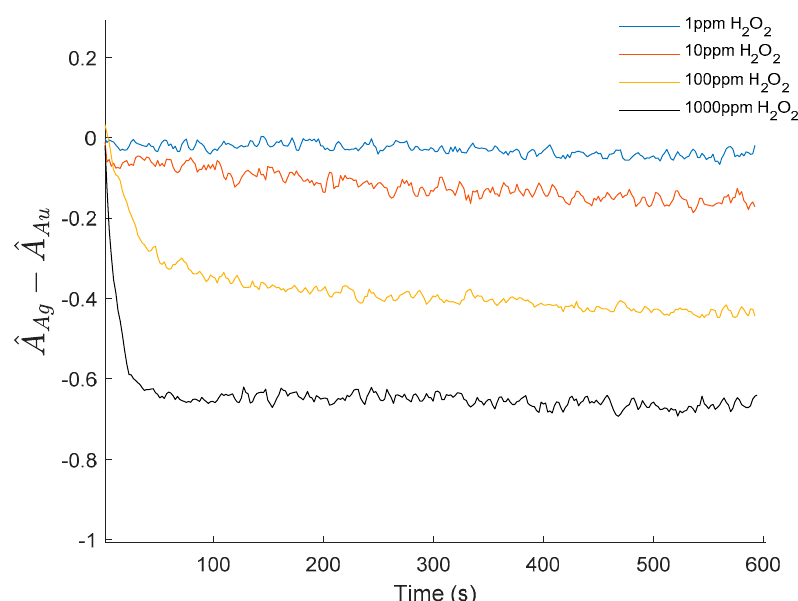
Figure 10. Time response of the difference between the normalized LSPR absorption bands of AgNPs and AuNPs. The response of this indicator is very similar to the direct read of the AgNPs LSPR maxima shown in Figure 5 for a simpler sensitive coating based only on AgNPs.